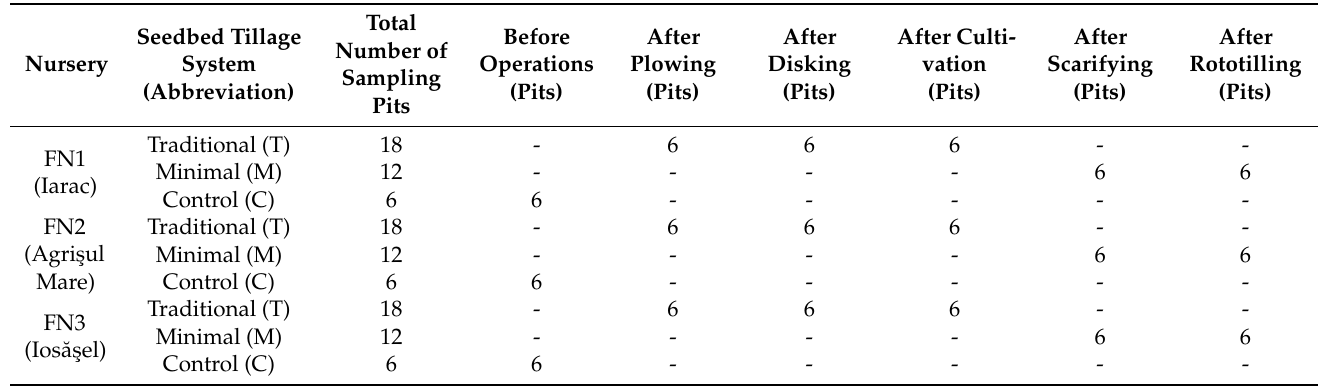
Table 4. Design of the soil sampling